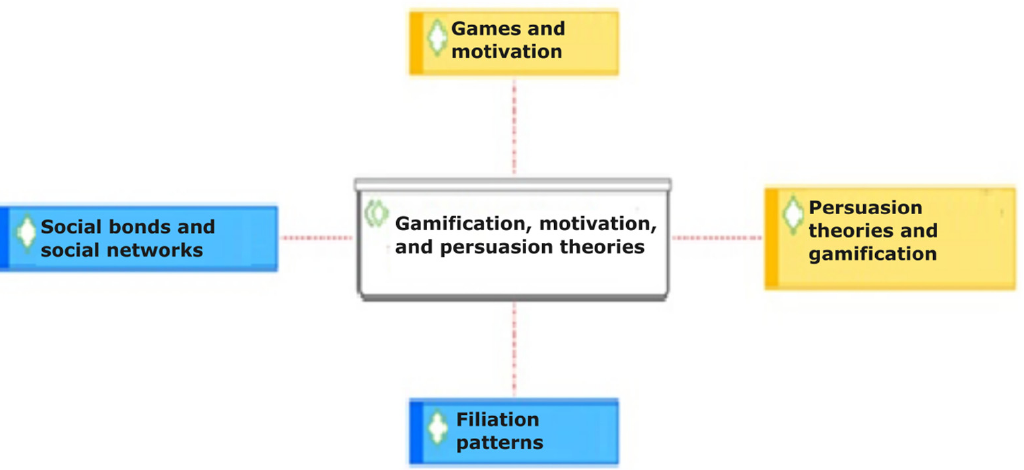
Figure 8. Serious games motivation and theories of persuasion. Source: Self-generated with the use of ATLAS.ti Software.